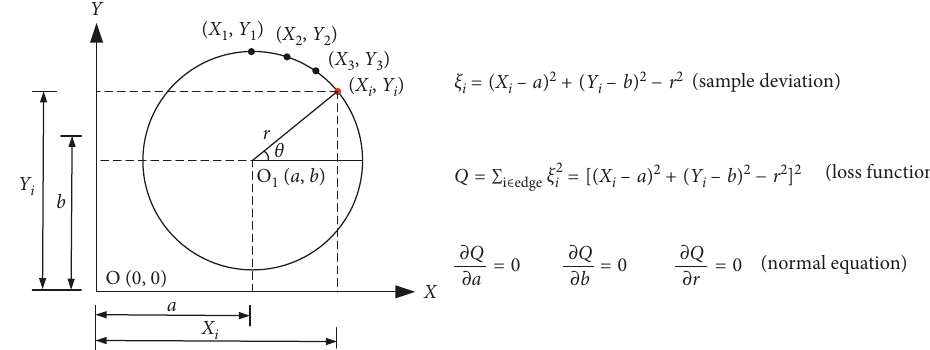
Figure 4: Schematic diagram of the circle detection